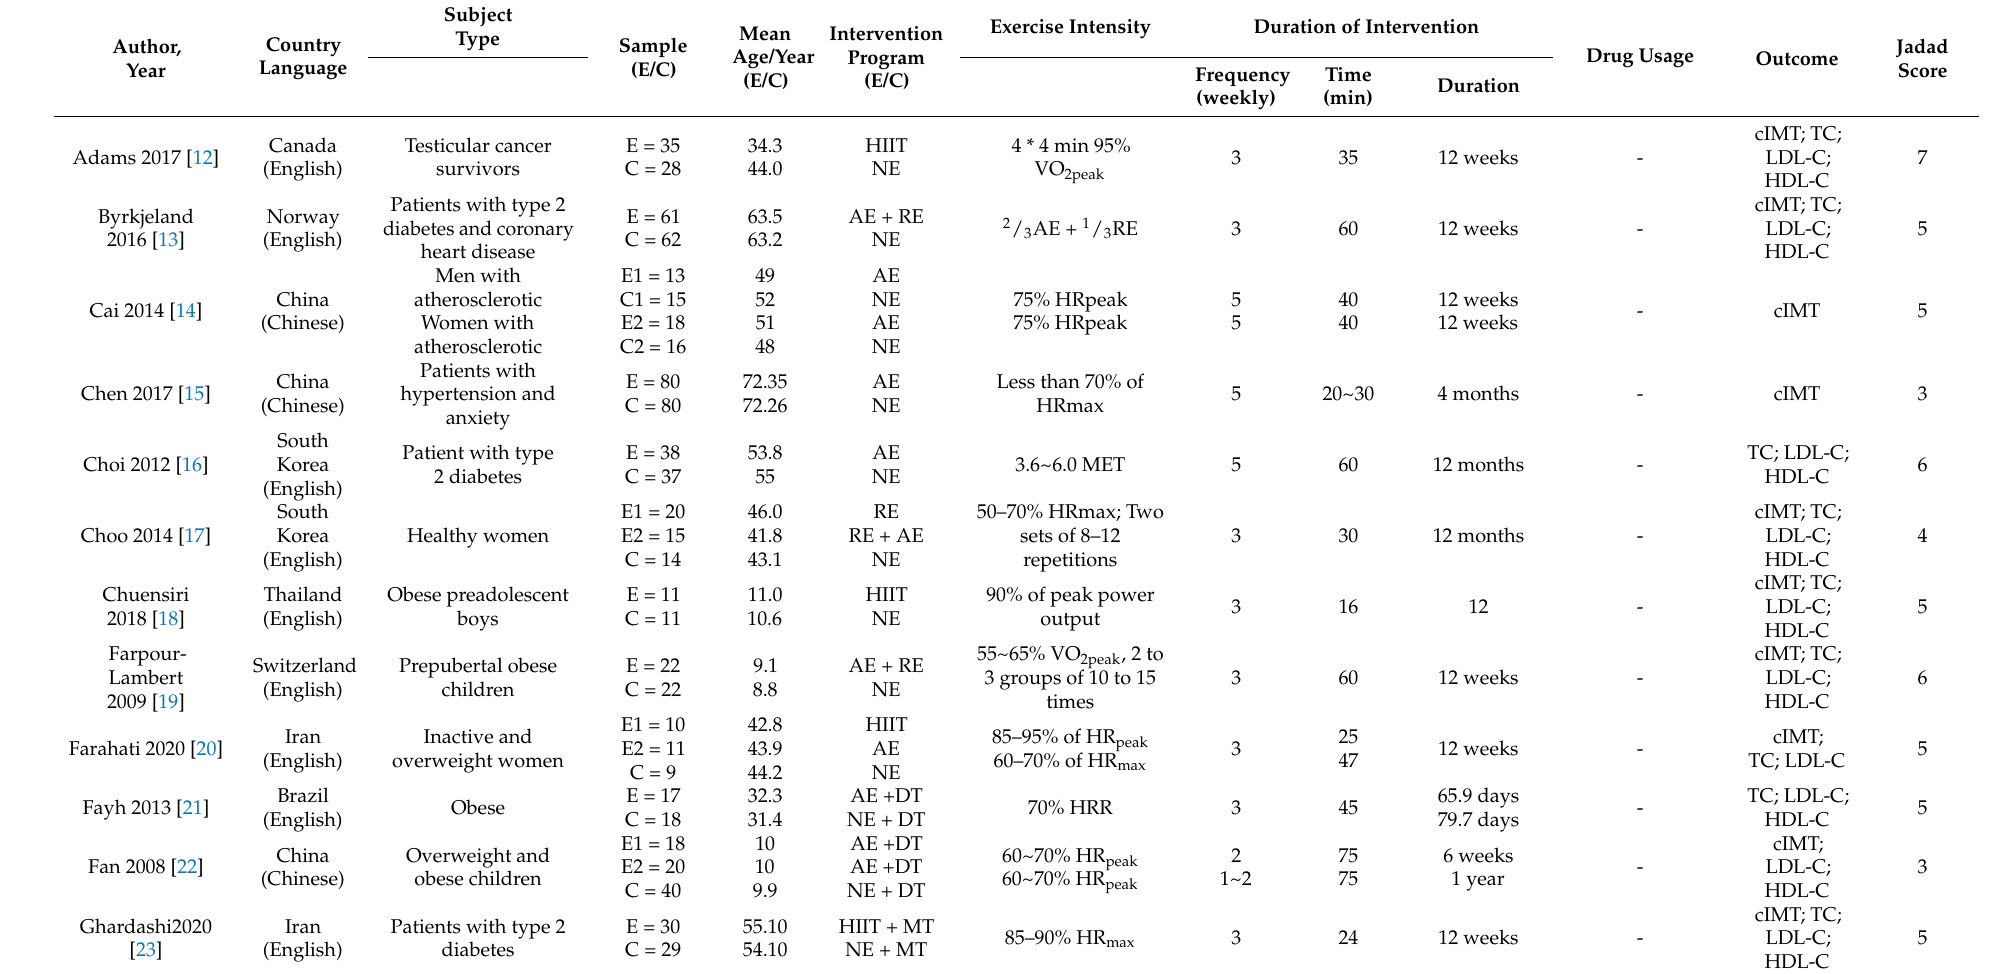
Table 1. The detailed characteristics of each selected